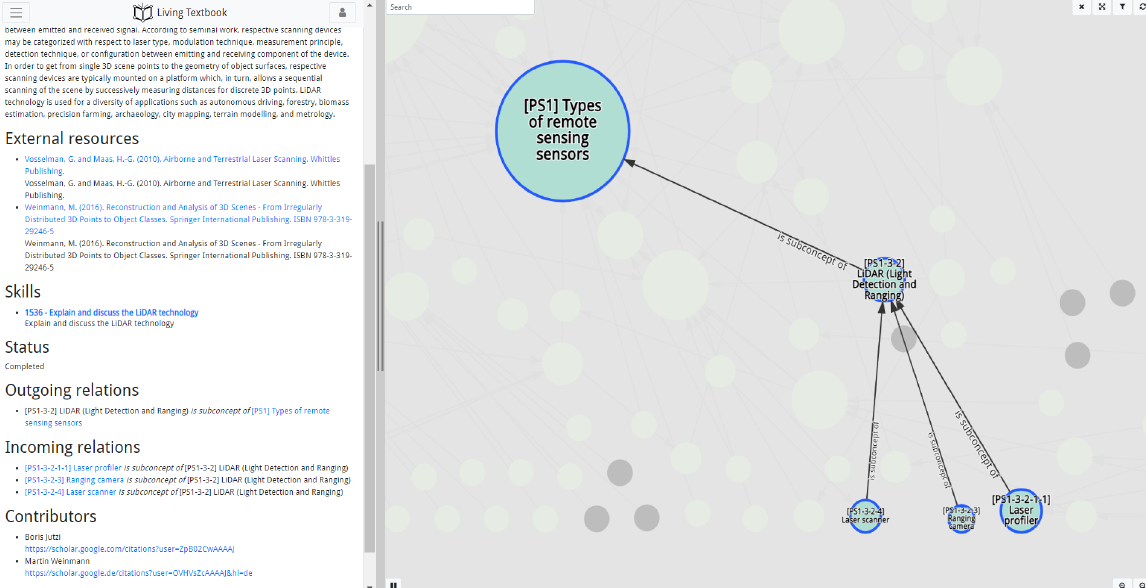
Figure 2 . Living Text Book page of the LiDAR concept with corresponding